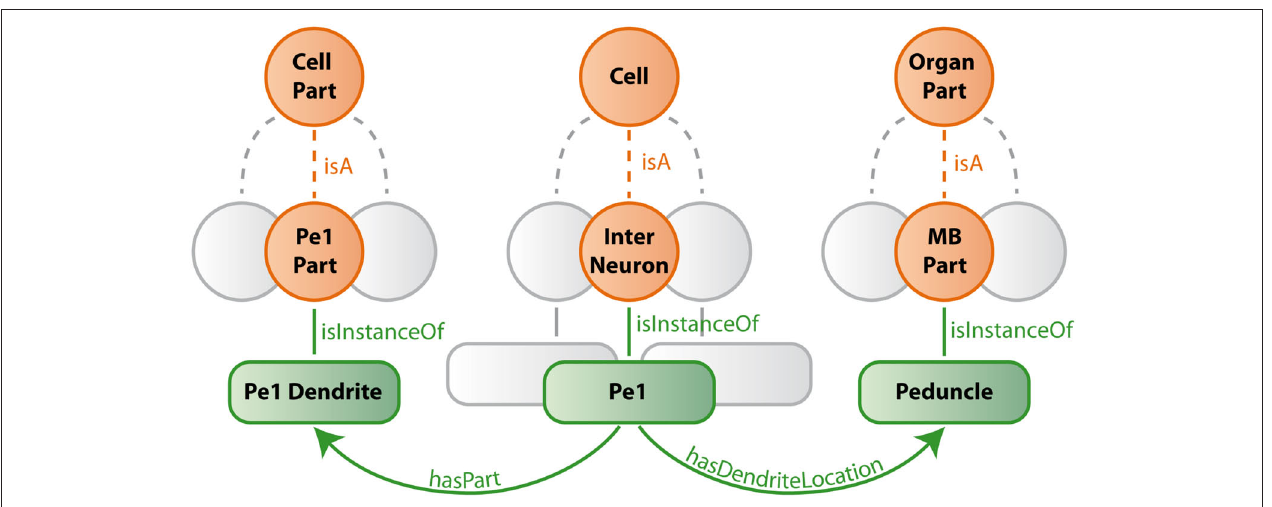
squares symbolize instances of classes which are connected by green edges (relations) to each other. Gray structures indicate that only a small selection is